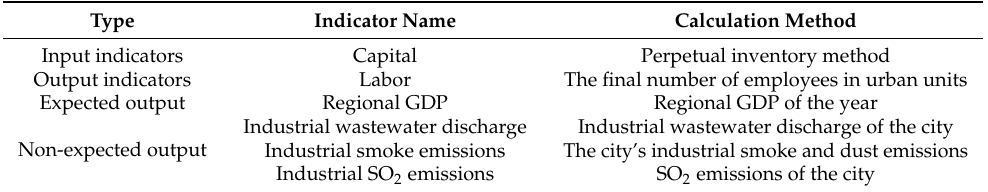
Table 6. Description of input and output